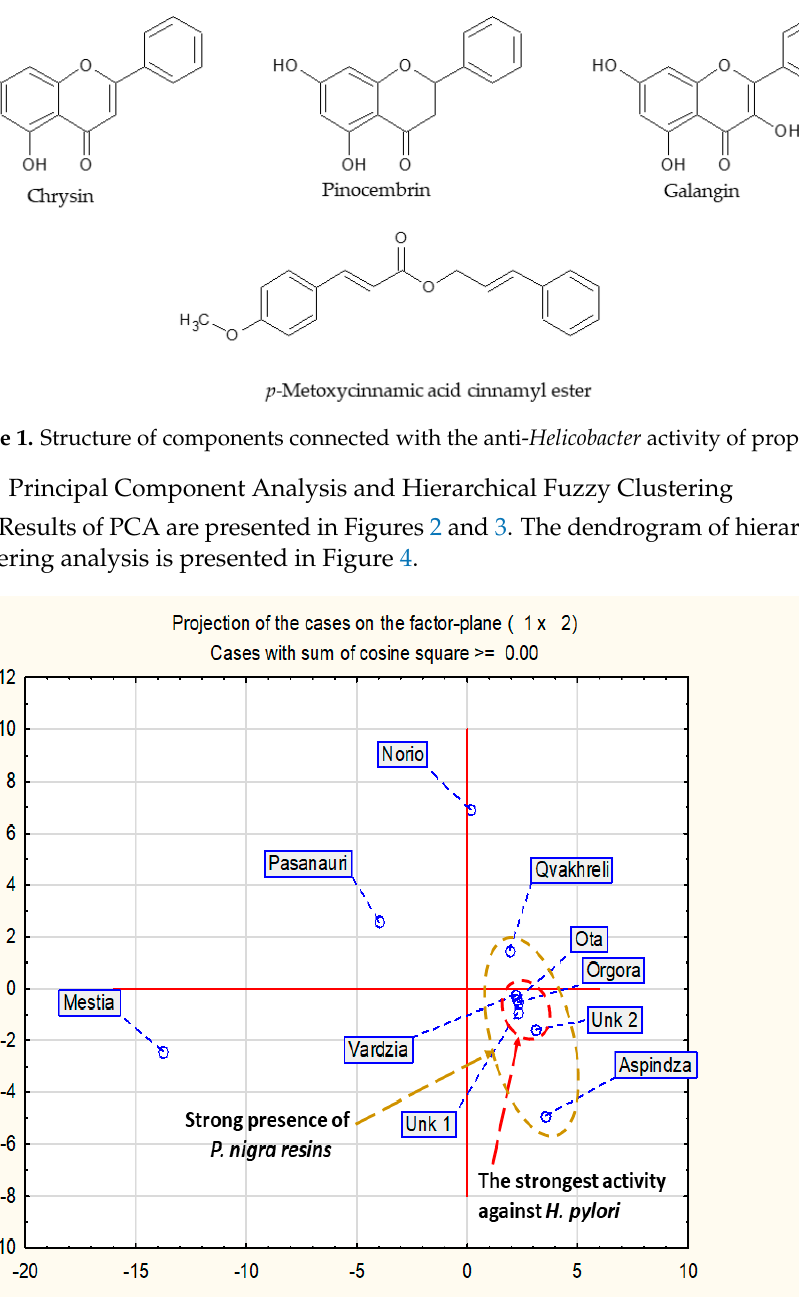
Figure 3. Projection of variables on the factor plane . The model based on two factors was sufficient to show 80.9% of presentation quality. Moreover, it is important to note that the most active samples against H. pylori were represented in one small cluster (MIC = 31.30 µg/mL). All of these samples exhibited black poplar origin with a dominance of flavonoids over the rest of the polyphenols. Samples outside this cluster exhibited weaker anti- Helicobacter activity. In summary, this result